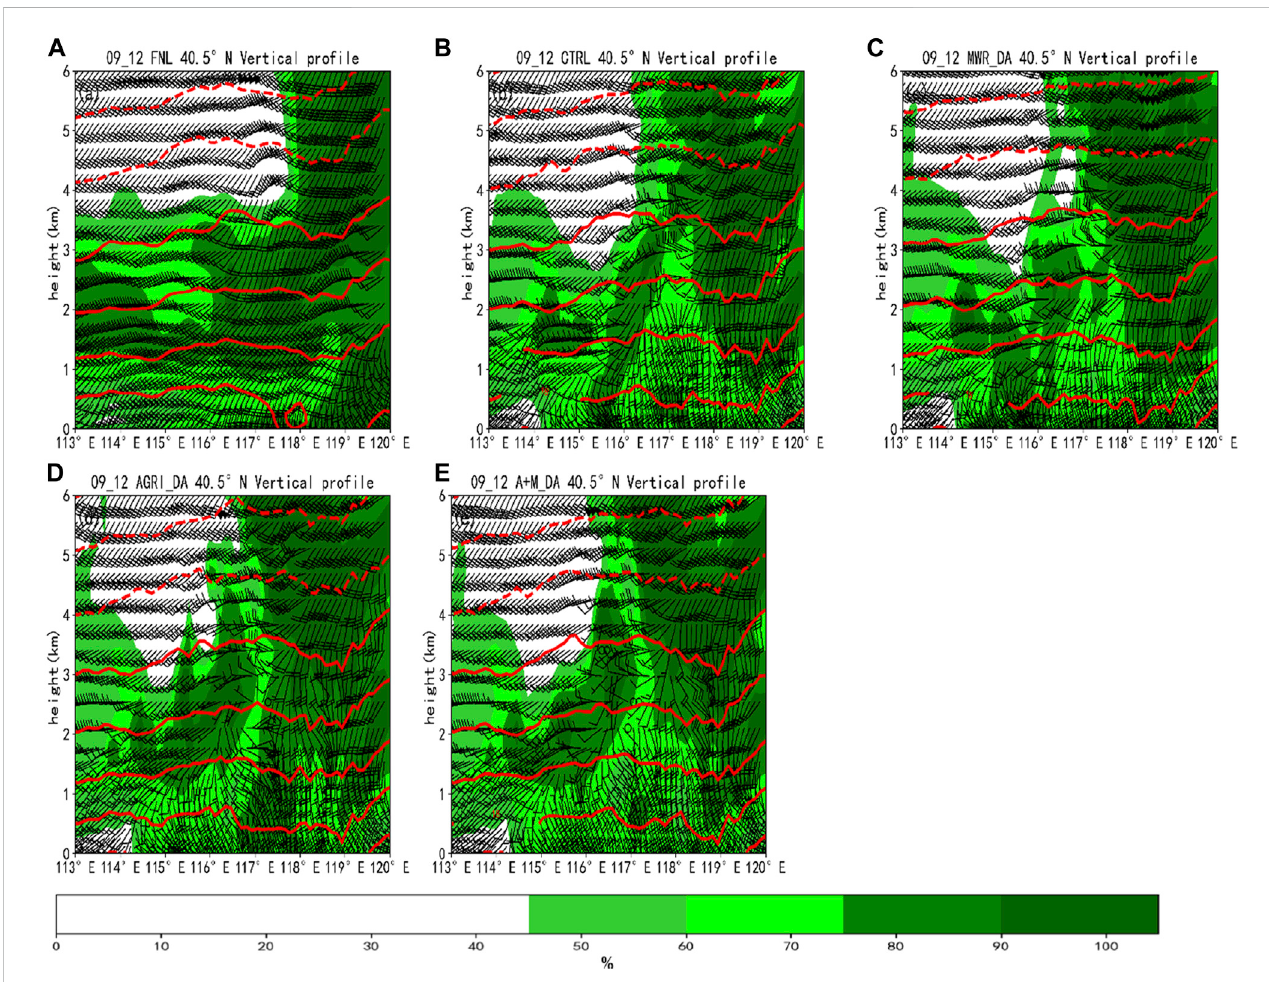
FIGURE 12 The vertical cross sections along 40.5 ° N from (A) FNL, (B) CTRL, (C) MWR_DA, (D) AGRI_DA, (E) A + M_DA at 1200 UTC, superimposed with the temperature (red contours), relative humidity (shaded), and horizontal wind